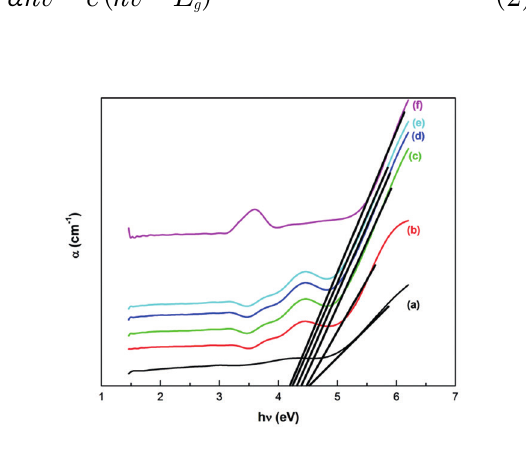
Figure 6: α vs hν plots of pure and Mn 2+ doped PVC polymer films (a) Pure (b) 1mol % (c) 2 mol % (d) 3 mol % (e) 4 mol% (f) 5 mol%.